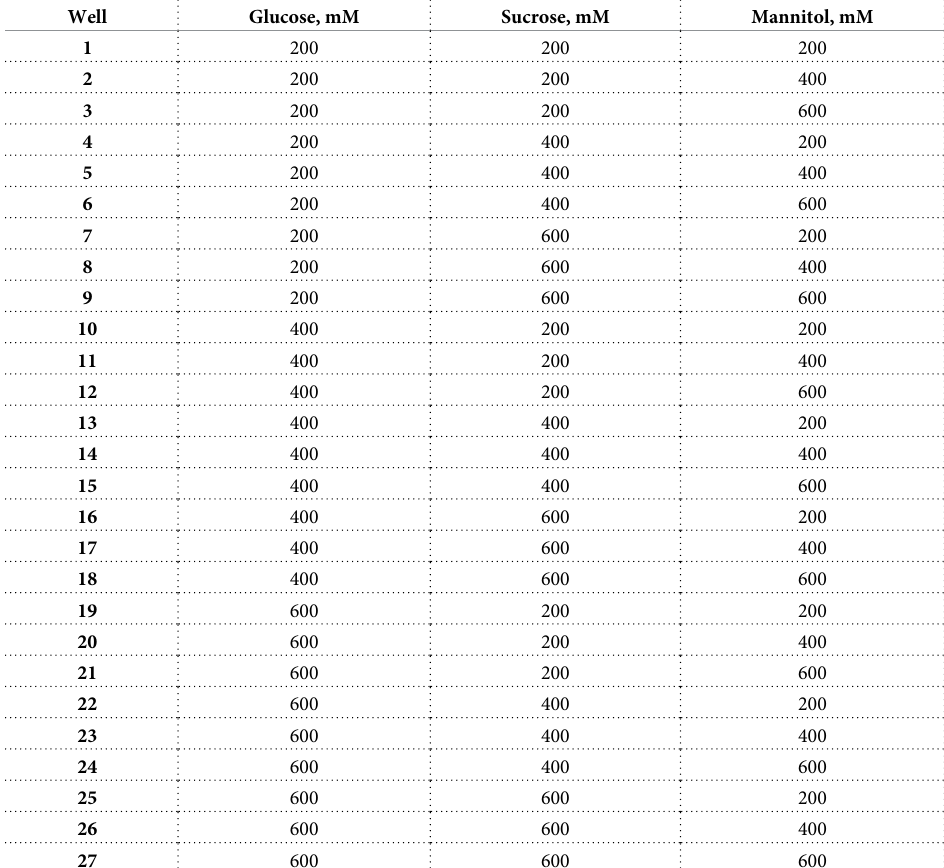
Table 7. Glucose, sucrose and mannitol concentrations optimization for GSM protein transduction. Well